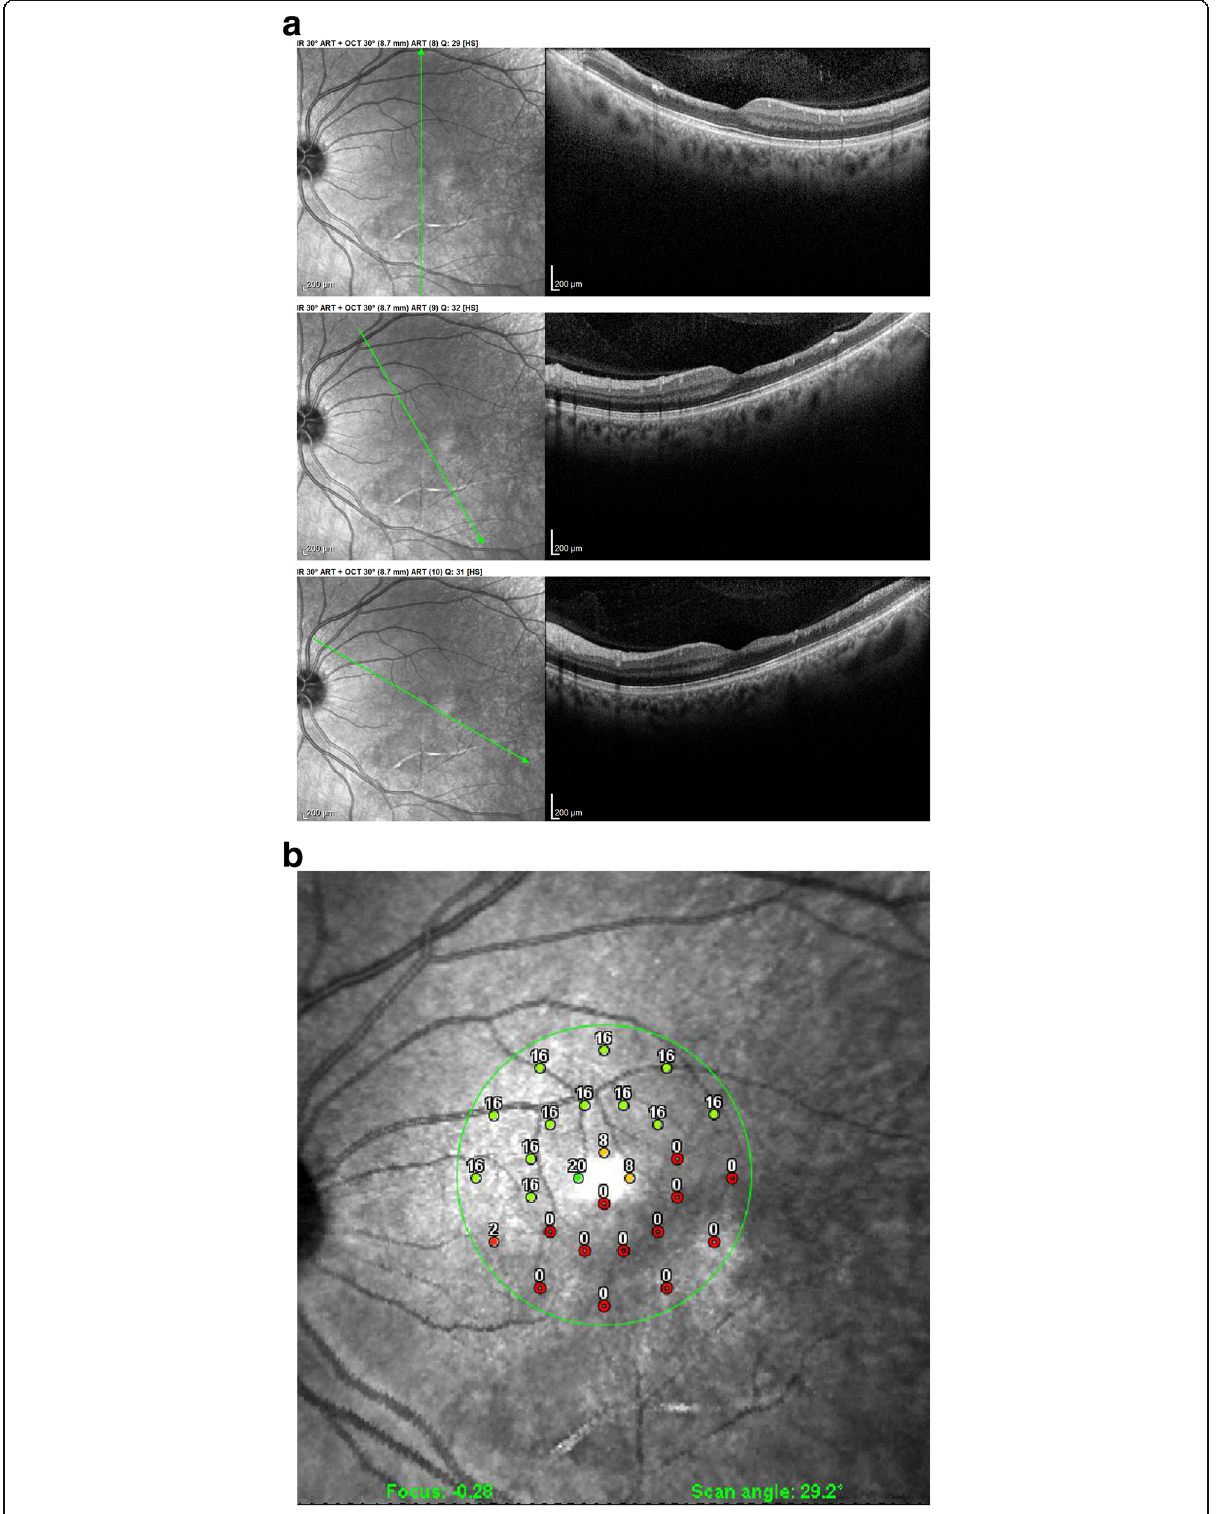
Fig. 4 a OCT imaging of the retina in a patient 4 months after retinal infarct showing atrophic thinning of the inner retina with conservation of the photoreceptor outer segments ellipsoid zone; note white course of involved artery on the SLO fundus picture (case 3). b Microperimetry clearly delineating the non-functional atrophic retinal area (case